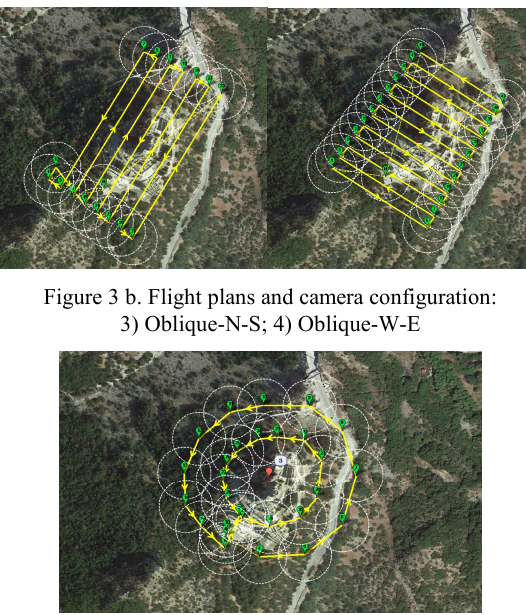
Figure 3 c. Flight plans and camera configuration: